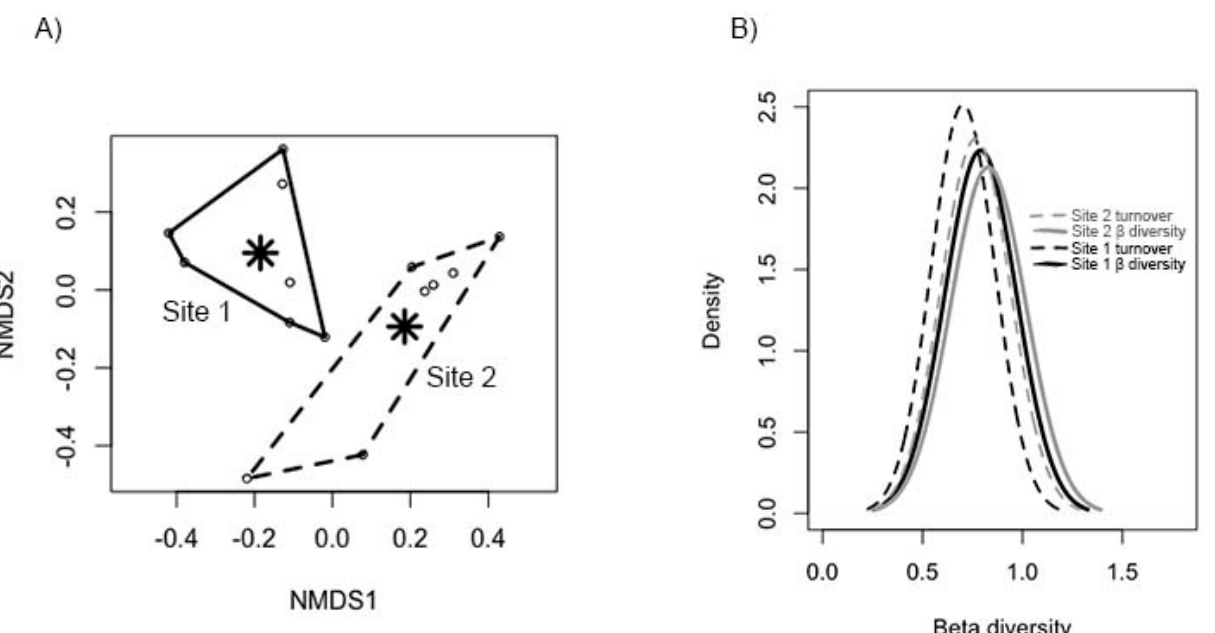
Figure 3. ( A ) Nonmetric multidimensional scaling (NMDS) convex hulls on log-transformed abun- dance data of the most abundant species of the beetle community divided by the two sites: Site 1 filled line convex hull and Site 2 dashed convex hull. Within each convex hull the * represents the centroid. The goodness of fit for Sites r 2 = 0.385, p -value = 0.004. ( B ) Beta diversity and species turnover for the two sites represent in a